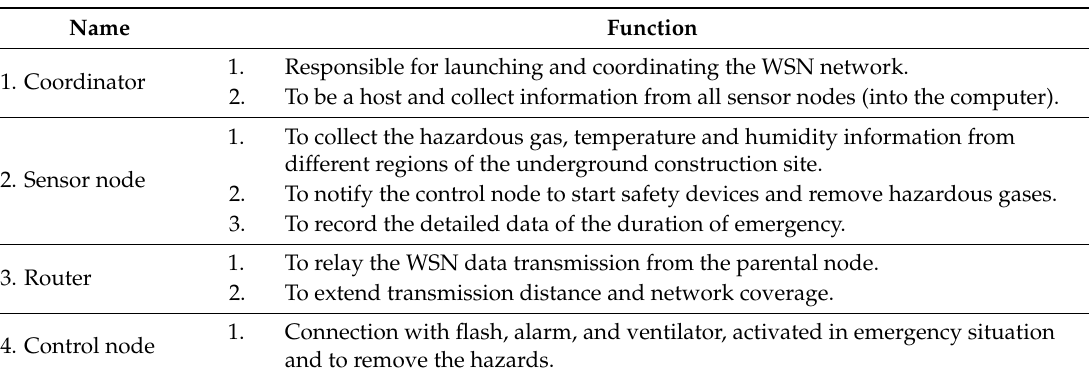
Table 3. The proposed WSN